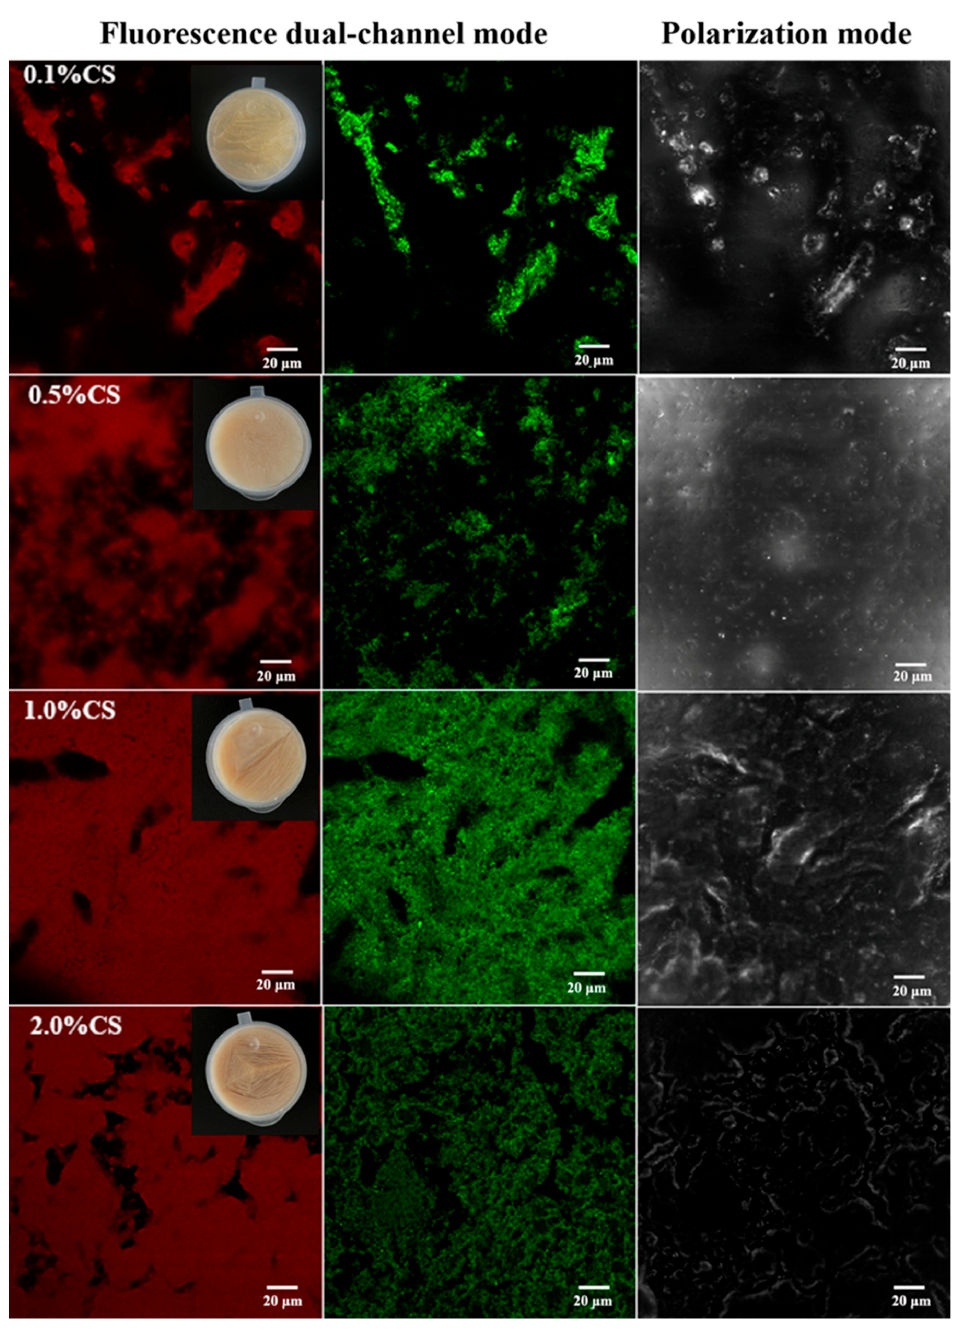
Figure 3. Confocal laser scanning microscope (CLSM) images of freeze-dried products from COBET with different CS content using fluorescence dual-channel mode and polarization mode. The lipid was labeled with Nile Red (in red) and the proteins was labeled with Nile Blue (in green). 0.1%CS, 0.5%CS, 1.0%CS, and 2.0%CS mean freeze-dried products from COBET containing 0.1%, 0.5%, 1.0%, 2.0% CS, respectively.